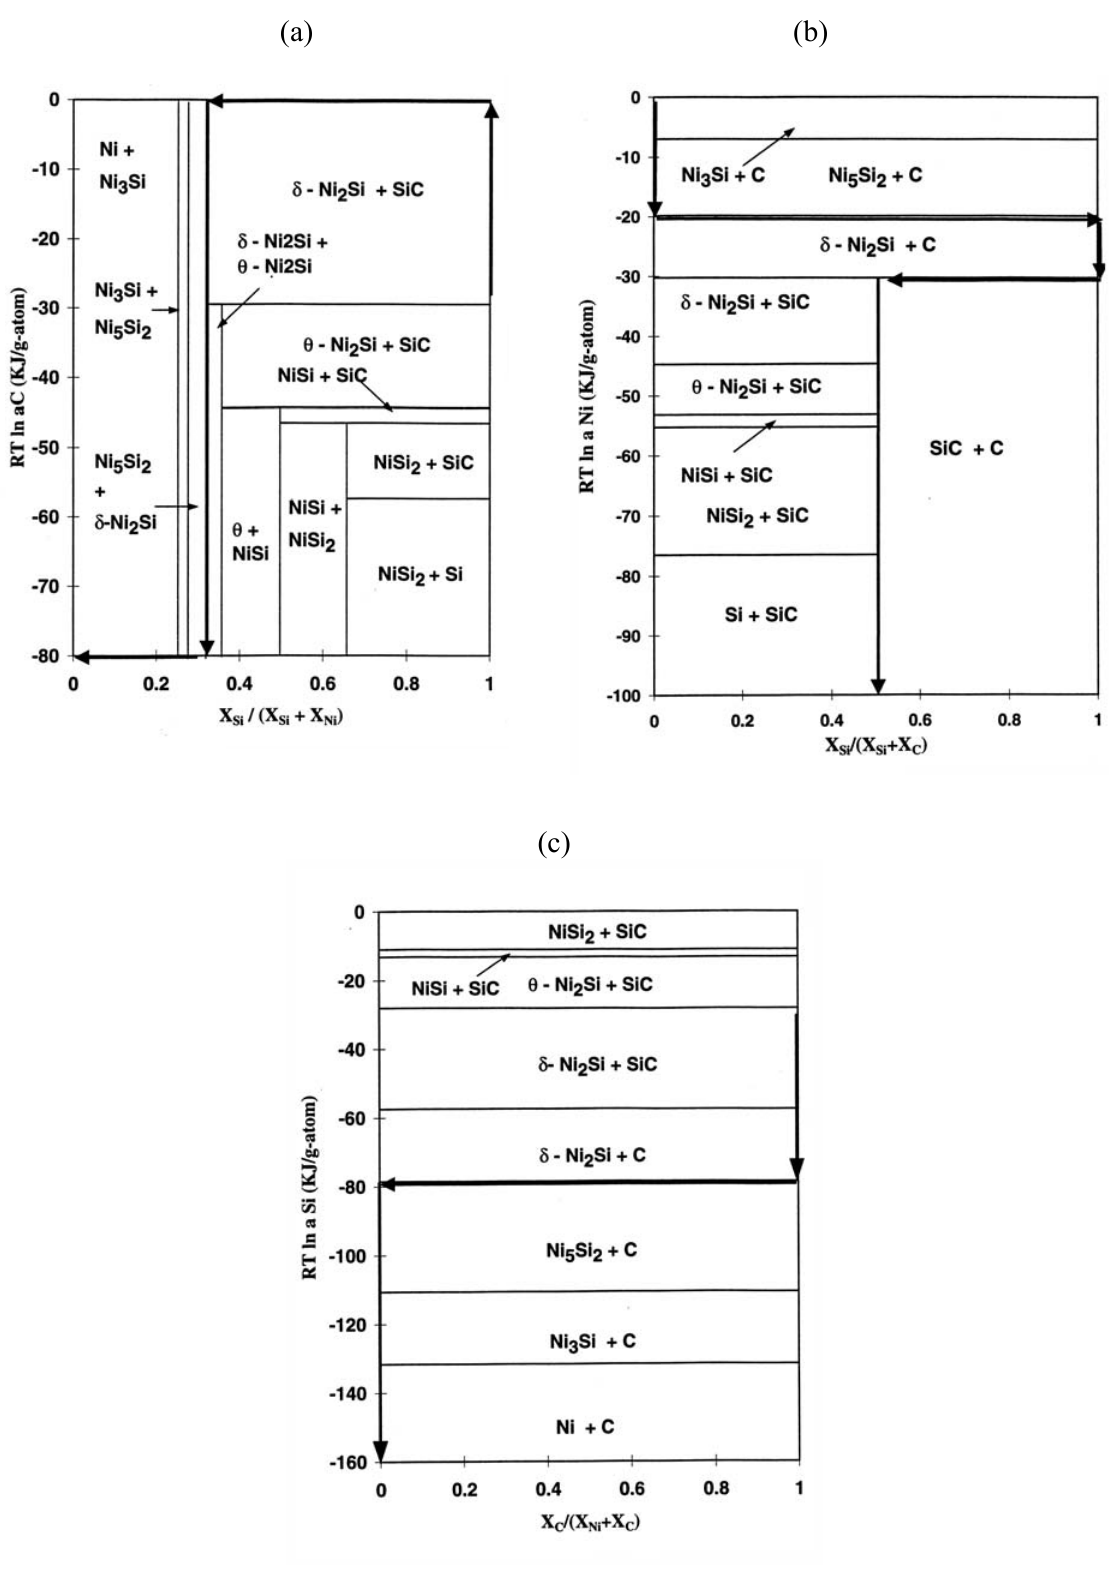
Figure 7. The chemical potential diagrams with diffusion pathway of the Si-C-Ni system (a) with respect to carbon, (b) with respect to nickel, (c) with respect to silicon